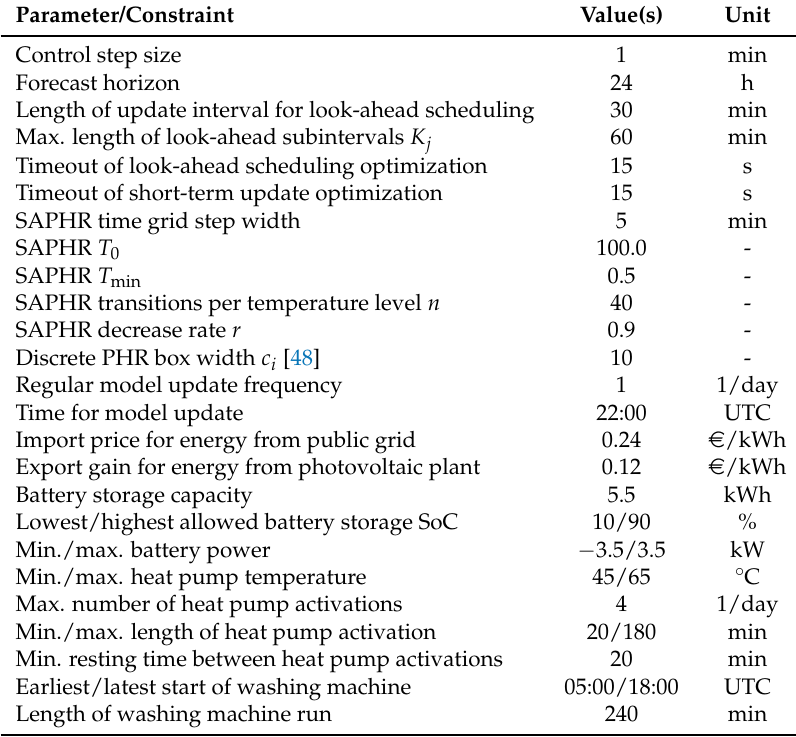
Table 5. Parameters and constraints used in the experimental